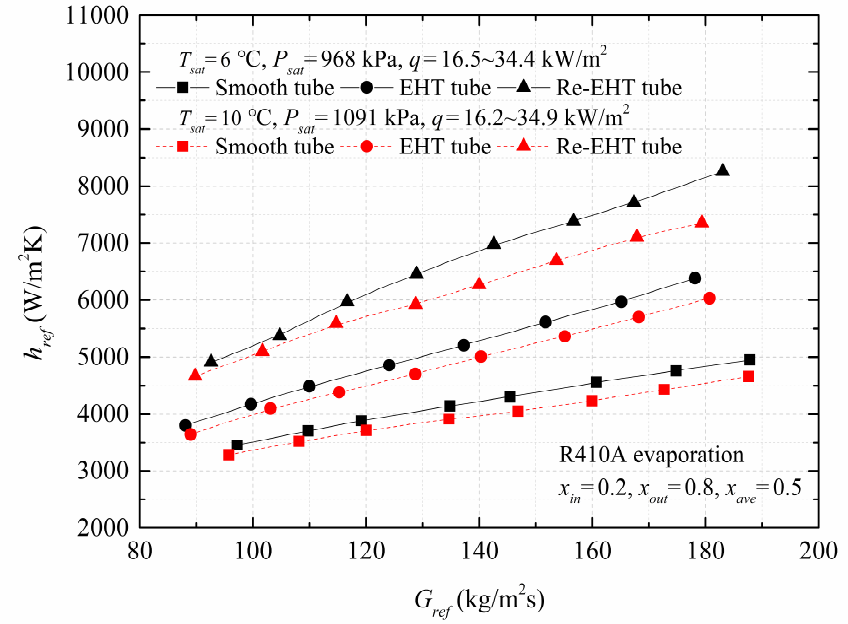
Figure 8. The effect of saturated temperature on the evaporating heat transfer in the test tubes.